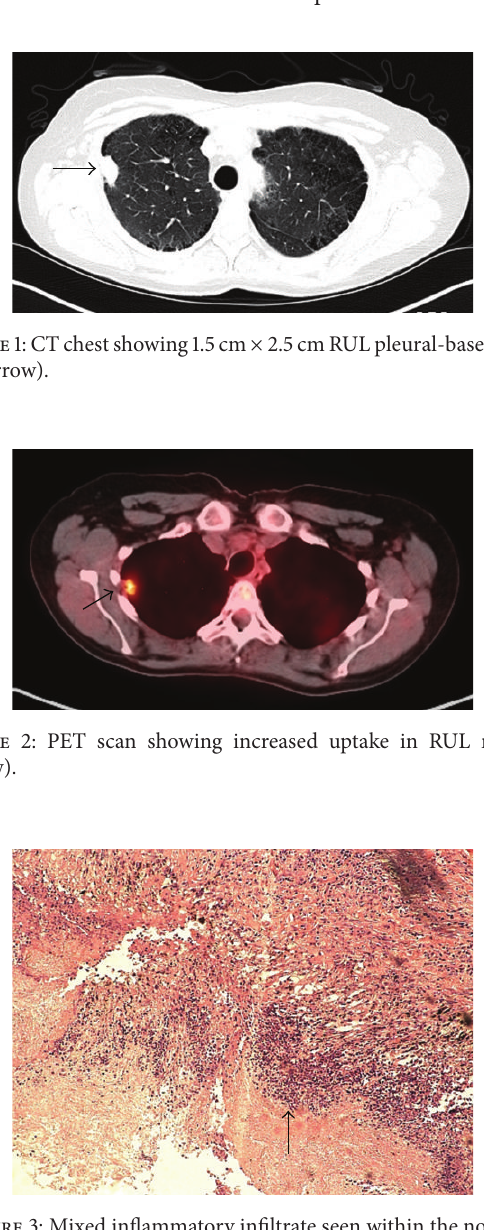
Figure 3: Mixed inflammatory infiltrate seen within the nodule.